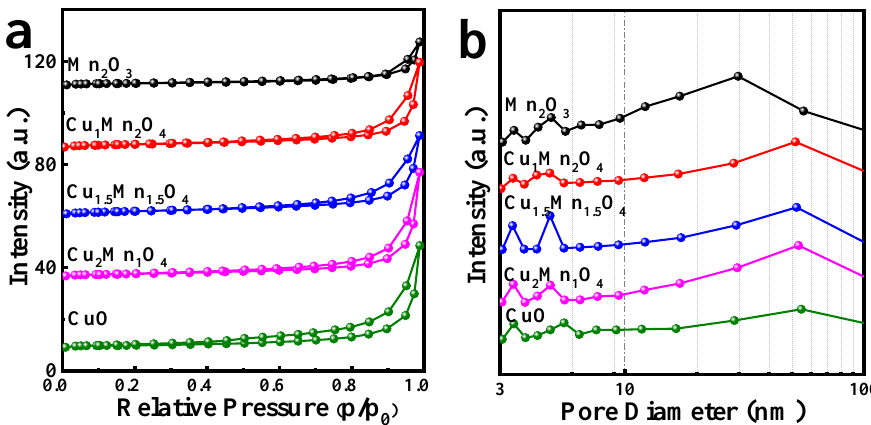
Figure 2. N 2 adsorption-desorption isotherms ( a ) and pore size distributions ( b ) of the as-synthesized Cu x Mn 3 − x O 4 samples.